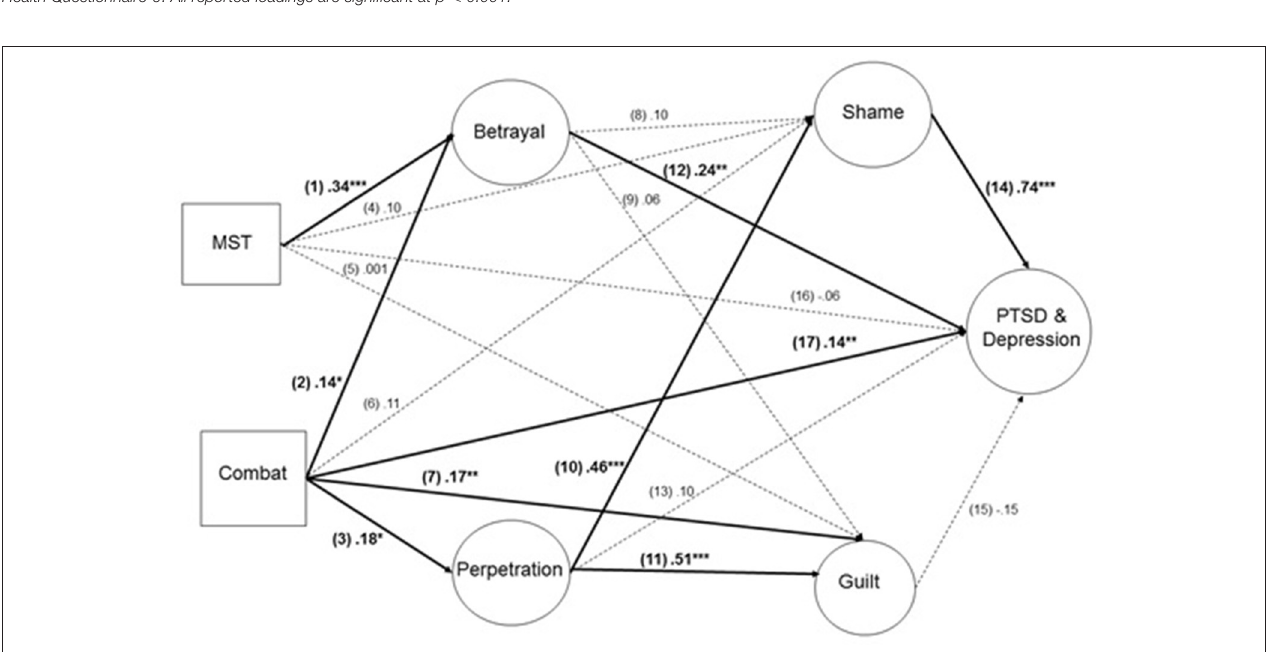
FIGURE 1 | Standardized path coefficients reported. Solid lines indicate significant paths and dashed lines indicate non-significant paths (p > 0.05). * p < 0.05, ** p < 0.001, *** p < 0.0001